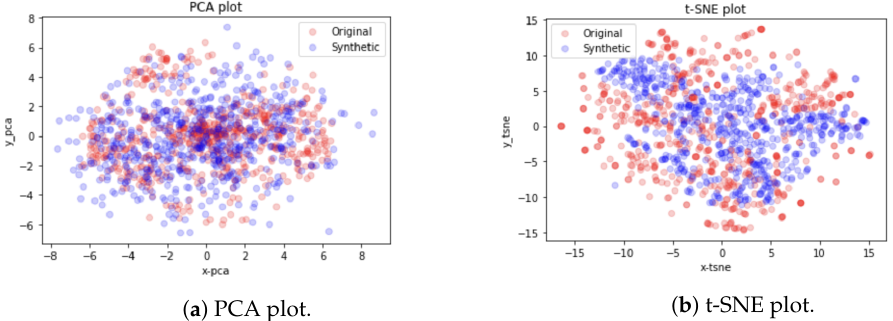
( a ) PCA plot. ( b ) t-SNE plot. Figure 14. PCA and t-SNE of generated and real data for jumping parameter for UniMIB dataset.